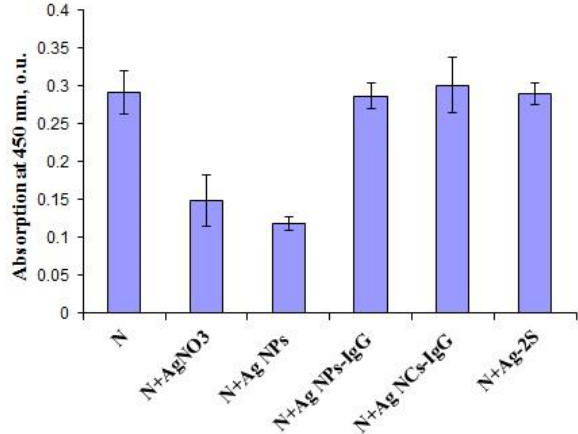
Figure 4. ELISA results for SARS-CoV-2 recombinant antigen N after incubation with AgNO 3 , Ag NPs, Ag NPs-IgG, Ag NCs-IgG and Ag-2S.